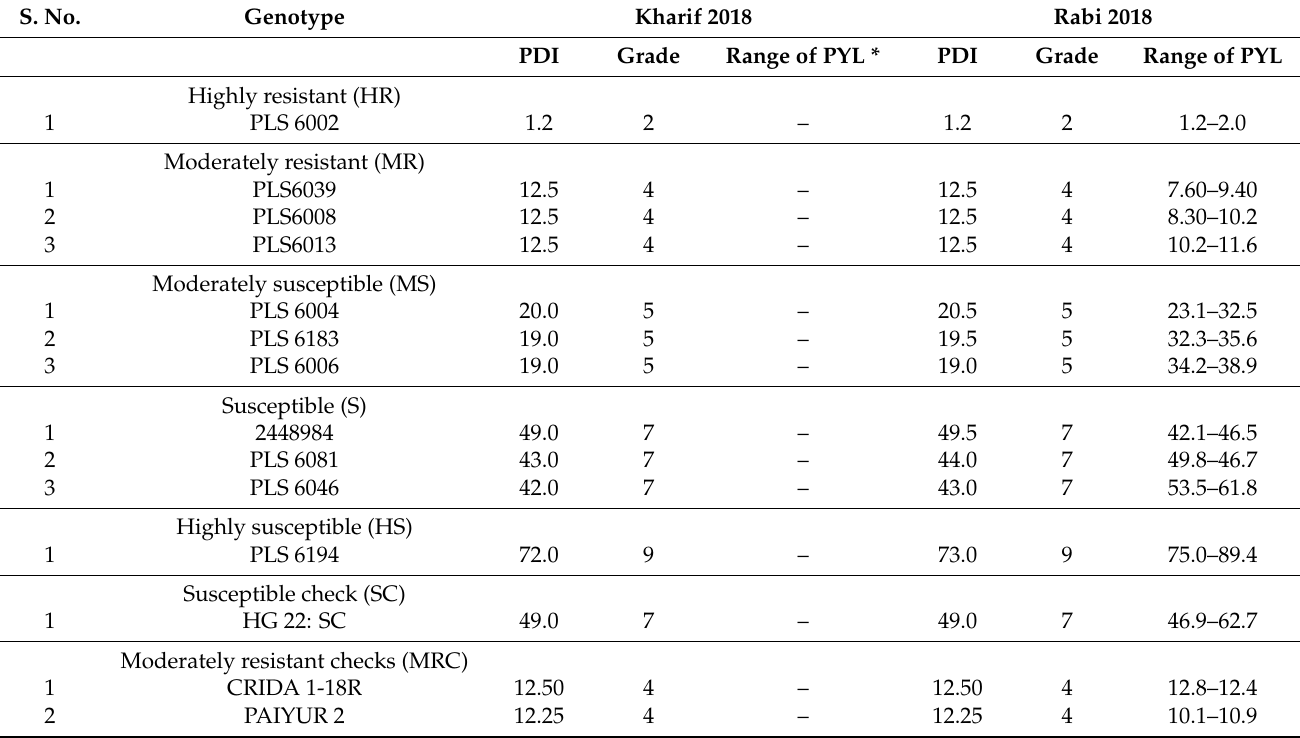
Table 2. Details of host-plant resistance and yield loss consequent to HgYMV infection in horse gram. S.